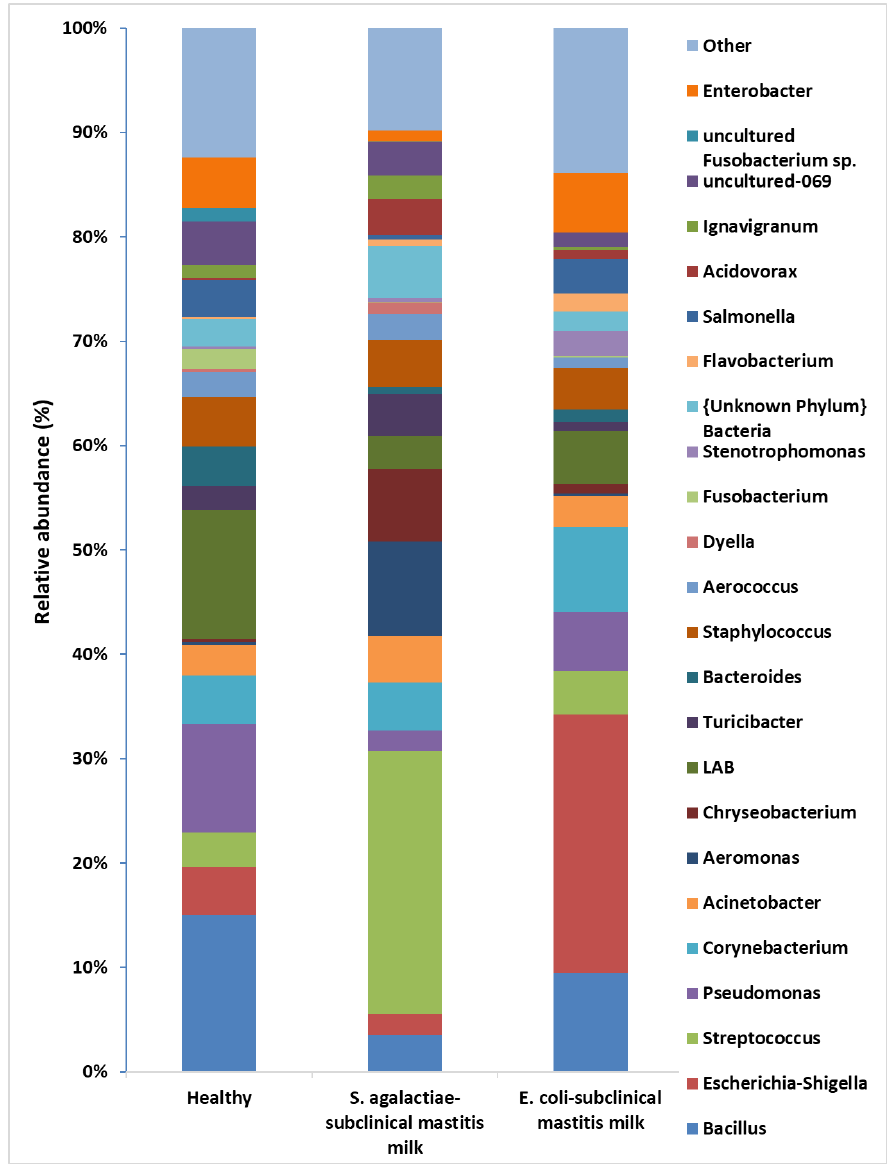
Figure 2. The relative abundance of bacterial genera in the milk from healthy cows and cows with subclinical mastitis. The values of the analyzed alpha-biodiversity coefficients in the metapopulation of microorganisms present in milk are given in Table 2. Estimates of intrasample diversity were made at a rarefaction depth of 80,000 reads per sample. There was a significant dif- ference in the number of identified operational taxonomic units (OTUs) in all tested trials. In all of the determined indicators, the microbiome of healthy cows was characterized by the greatest biodiversity (Table 2).